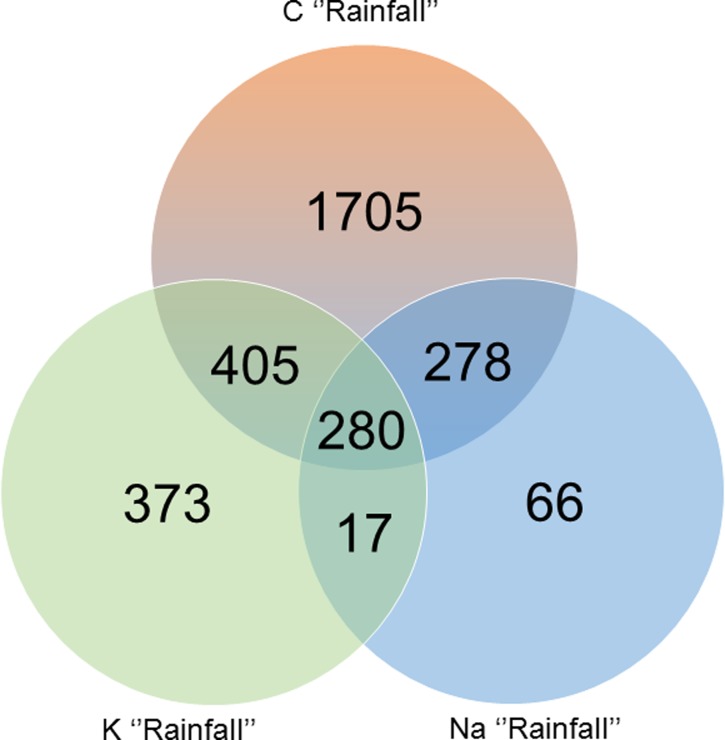
Venn diagram of Rainfall DEGs.